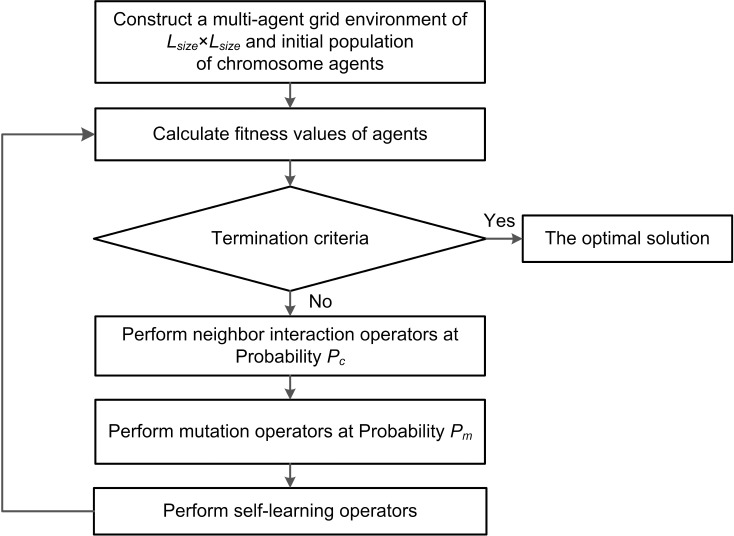
Flow chart of MAGA.